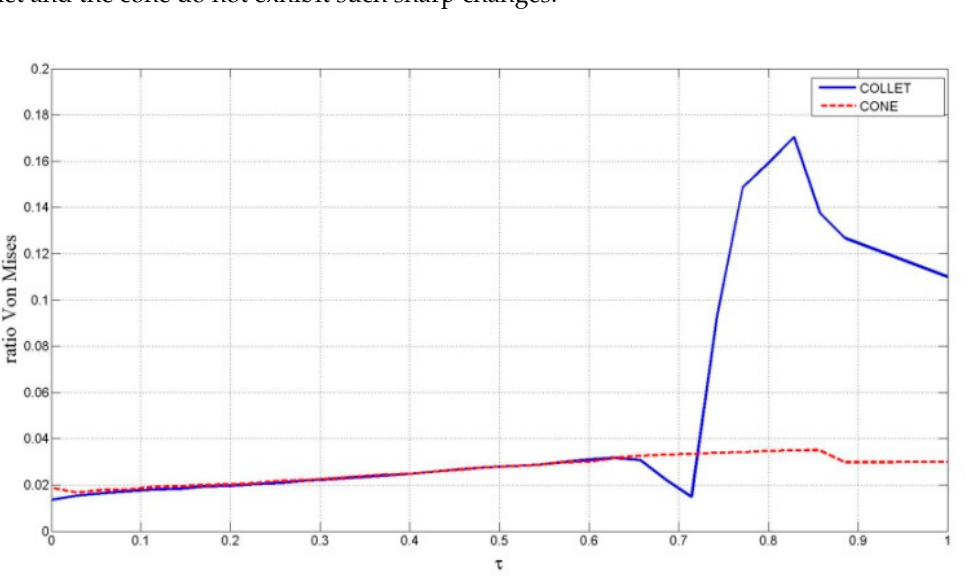
Figure 20. Expanding mandrel prototype within the air sensing system.